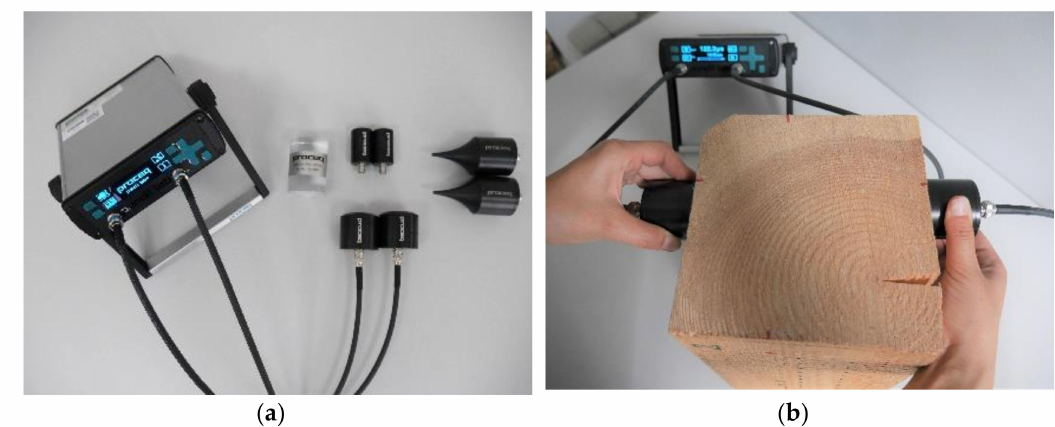
Figure 5. Apparatus for non-destructive test (NDT) studies: ( a ) PunditLab Proceq with accessories; ( b ) Sample under